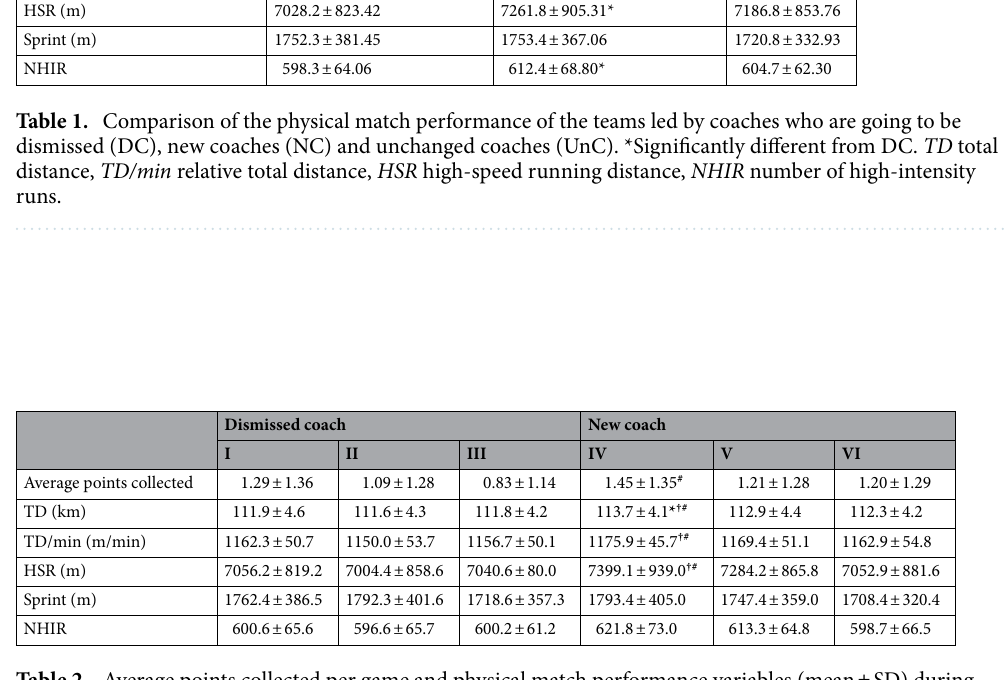
Table 2. Average points collected per game and physical match performance variables (mean ± SD) during 5-match periods for dismissed and new coaches. I: average points collected by dismissed coaches in a period between match -15 and -10; II: between match -10 and -5; III: in last 5 matches; IV: average points collected by new coaches in their first 5 matches; V: in a period between 5 and 10 match; VI: between match 10 and 15. *Significantly different from I. † Significantly different from II. # Significantly different from